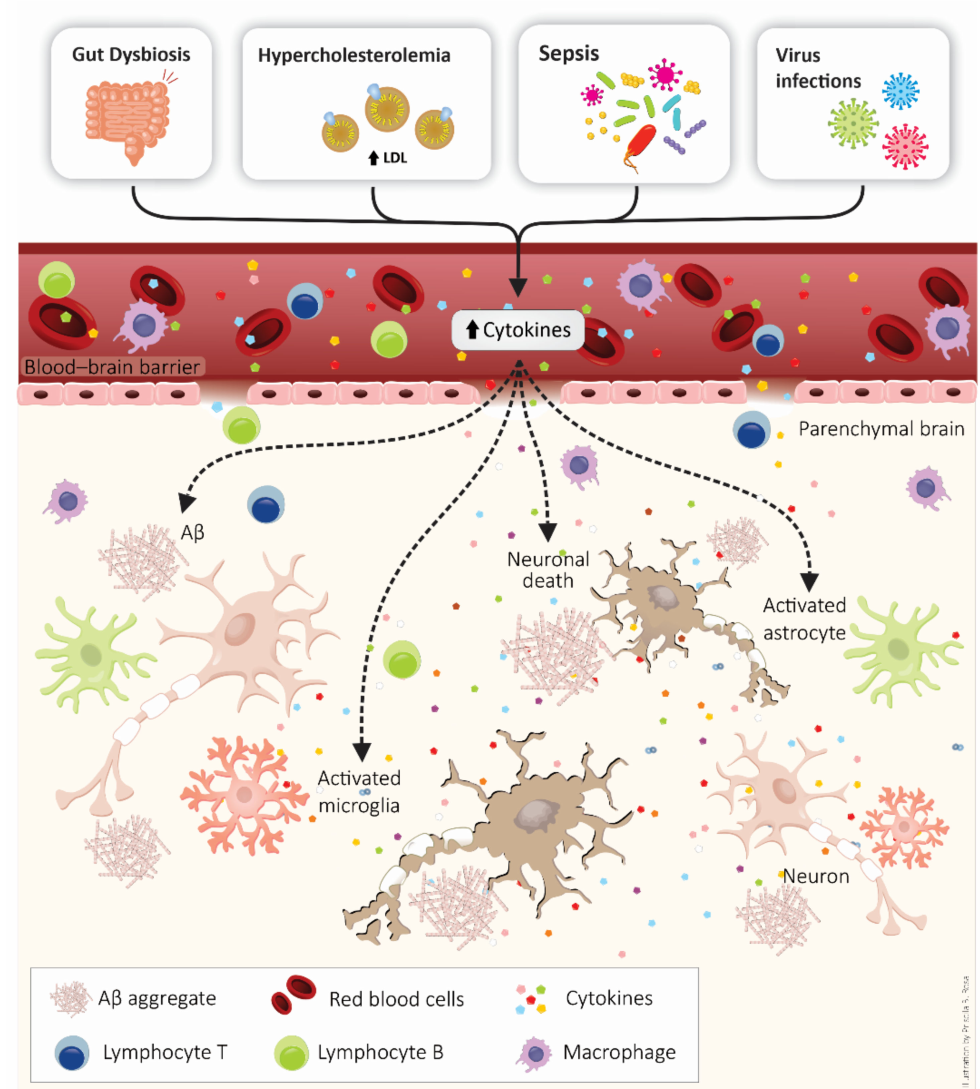
Figure 2. Peripheral diseases are a risk factor for β -amyloid peptide (A β ) peptide accumulation, neurodegeneration, and Alzheimer’s disease development. Systemic inflammatory conditions, such as metabolic disease, sepsis, virus infections, and dysbiosis, are associated with blood–brain barrier (BBB) disruption and coexistent neuroinflammation. Neuroinflammation is characterized by the presence of the peripheral immune system, activation of glial cells (astrocytes and microglia), and increased production of pro-inflammatory molecules (e.g.,